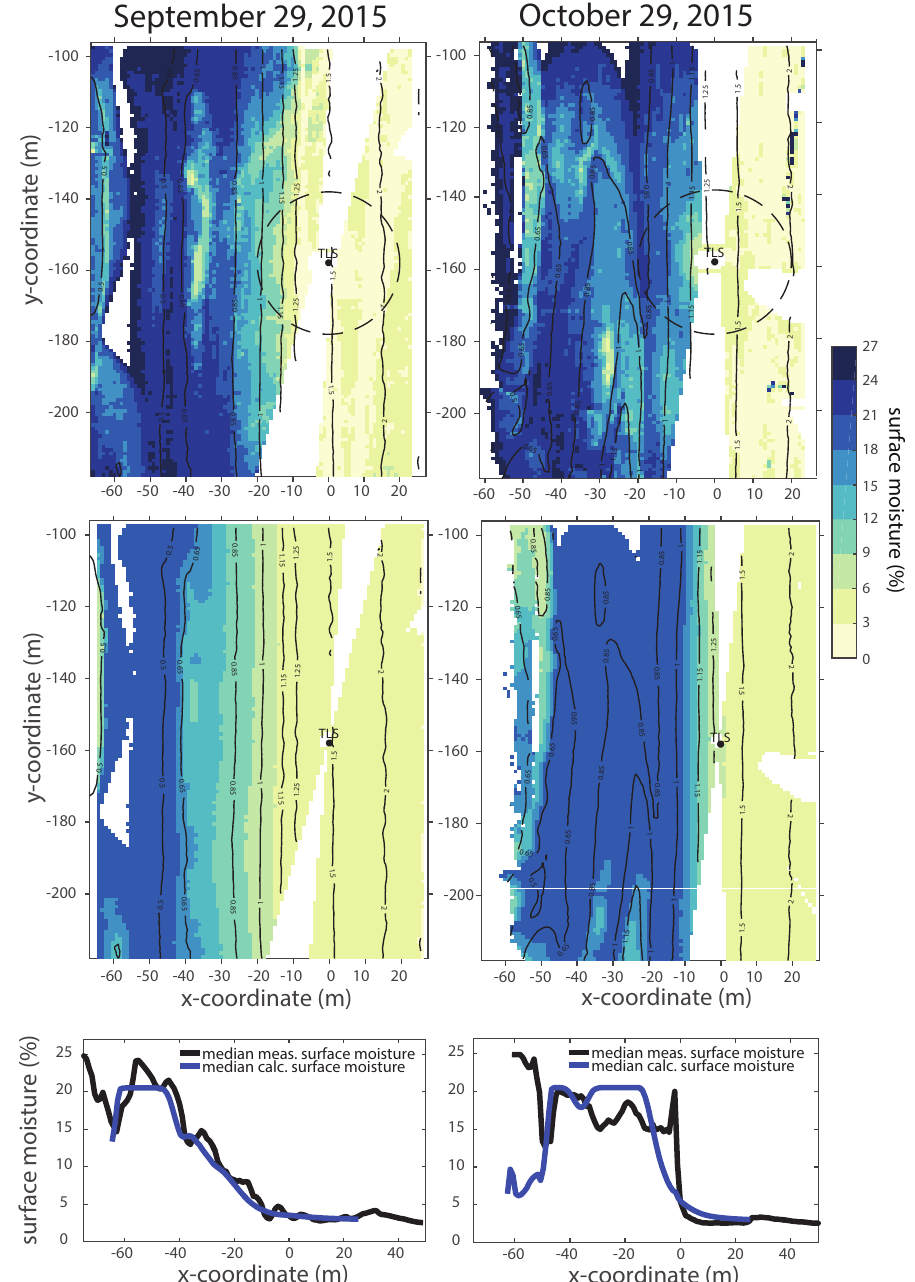
Figure 12. Measured (top row) versus calculated (middle row) surface moisture maps, presented in a 1 × 1 m grid, taken on 29 September 2015. The bottom row shows the median of all surface moisture measurements along the same x -coordinate for 18 measured surface moisture maps (black line) and 18 calculated surface moisture maps (blue line), for the same time steps as the measured surface moisture maps. Note: both lines show the same pattern and beach